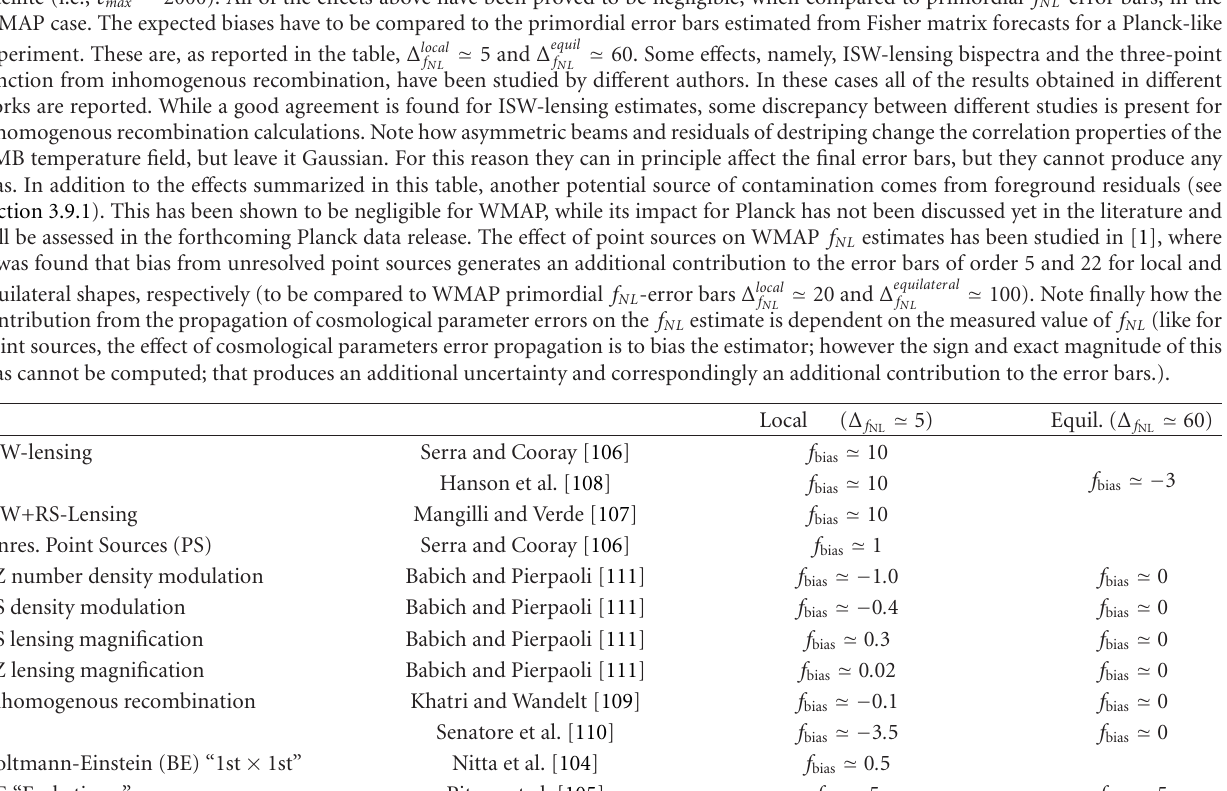
Table 4: Expected contamination on f NL measurements from secondary bispectra (see Section 3.9.3) and from the e ff ects described in Section 3.9.5. The expected bias of the primordial f NL estimate is given for local and equilateral shapes (if not reported, that means that the corresponding shape has not been studied). All of the estimates above are for an experiment with the angular resolution of the Planck satellite (i.e., (cid:9) max ∼ 2000). All of the e ff ects above have been proved to be negligible, when compared to primordial f NL -error bars, in the WMAP case. The expected biases have to be compared to the primordial error bars estimated from Fisher matrix forecasts for a Planck-like (cid:10) 5 and Δ equil (cid:10) 60. Some e ff ects, namely, ISW-lensing bispectra and the three-point experiment. These are, as reported in the table, Δ local f NL f NL function from inhomogenous recombination, have been studied by di ff erent authors. In these cases all of the results obtained in di ff erent works are reported. While a good agreement is found for ISW-lensing estimates, some discrepancy between di ff erent studies is present